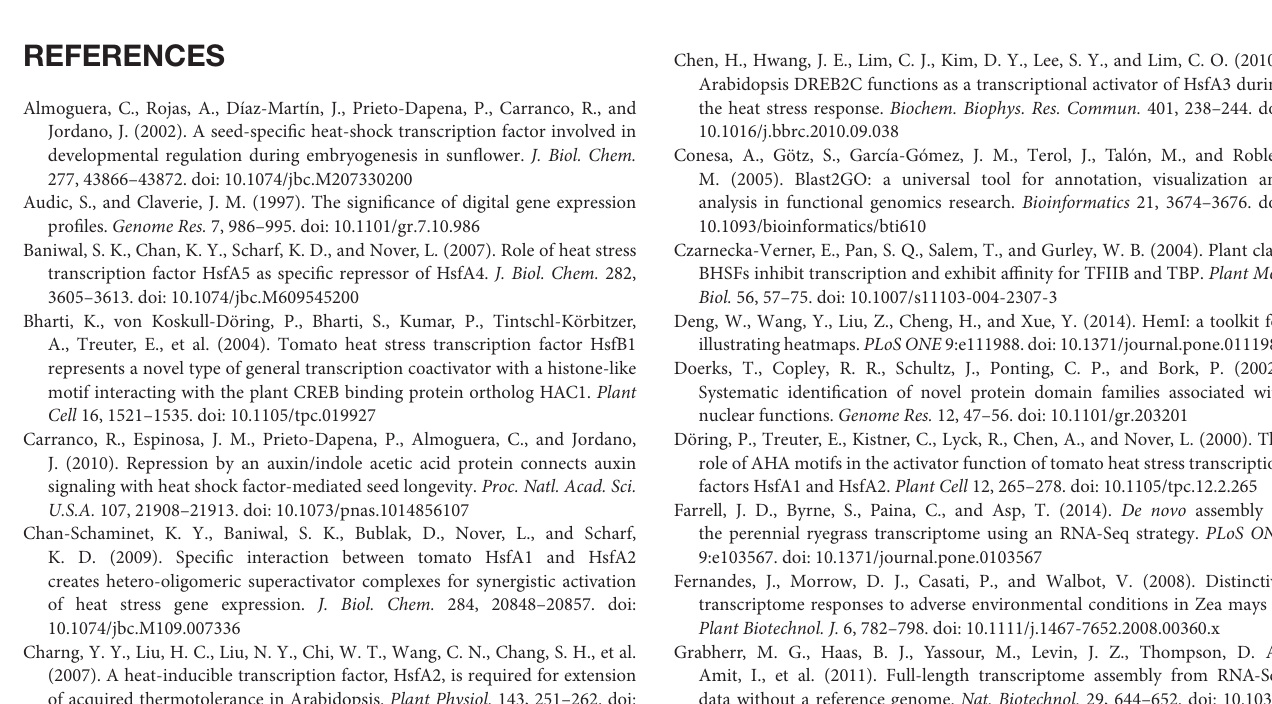
Supplementary Figure 2 | Functional classification using Clusters of Orthologous Groups of proteins (COG) in tall fescue (A) and perennial ryegrass (B)